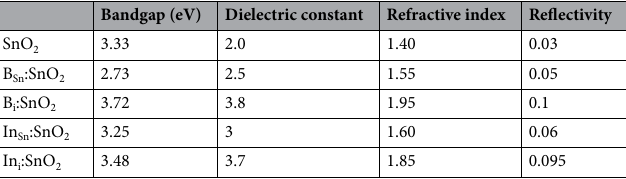
Table 2. The calculated electronic and optical